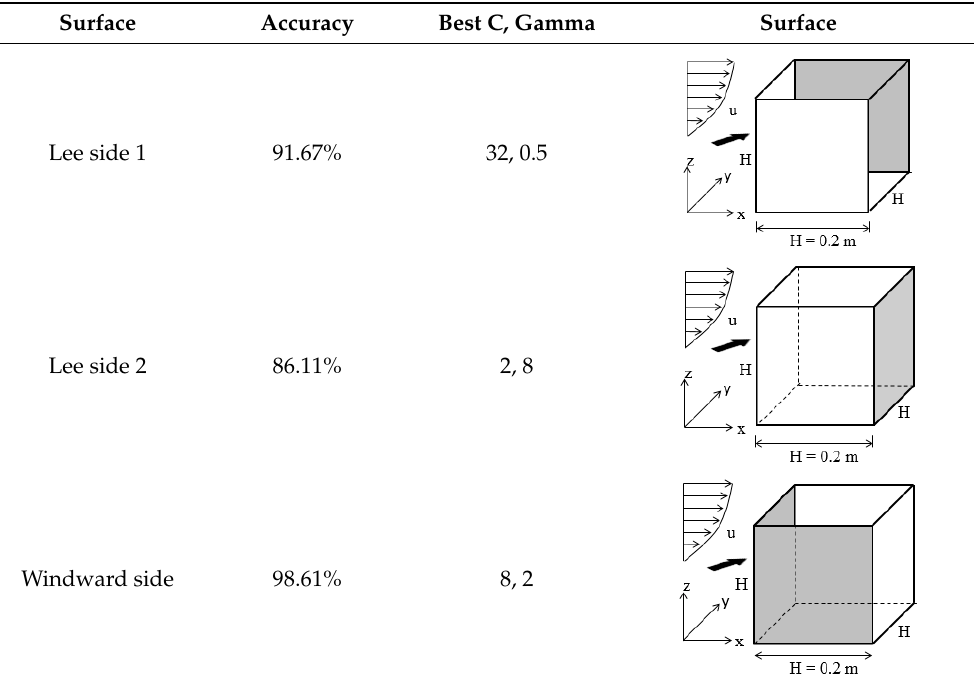
Table 7. SVM fitting models under the 30 ◦ and 45 ◦ wind direction condition.